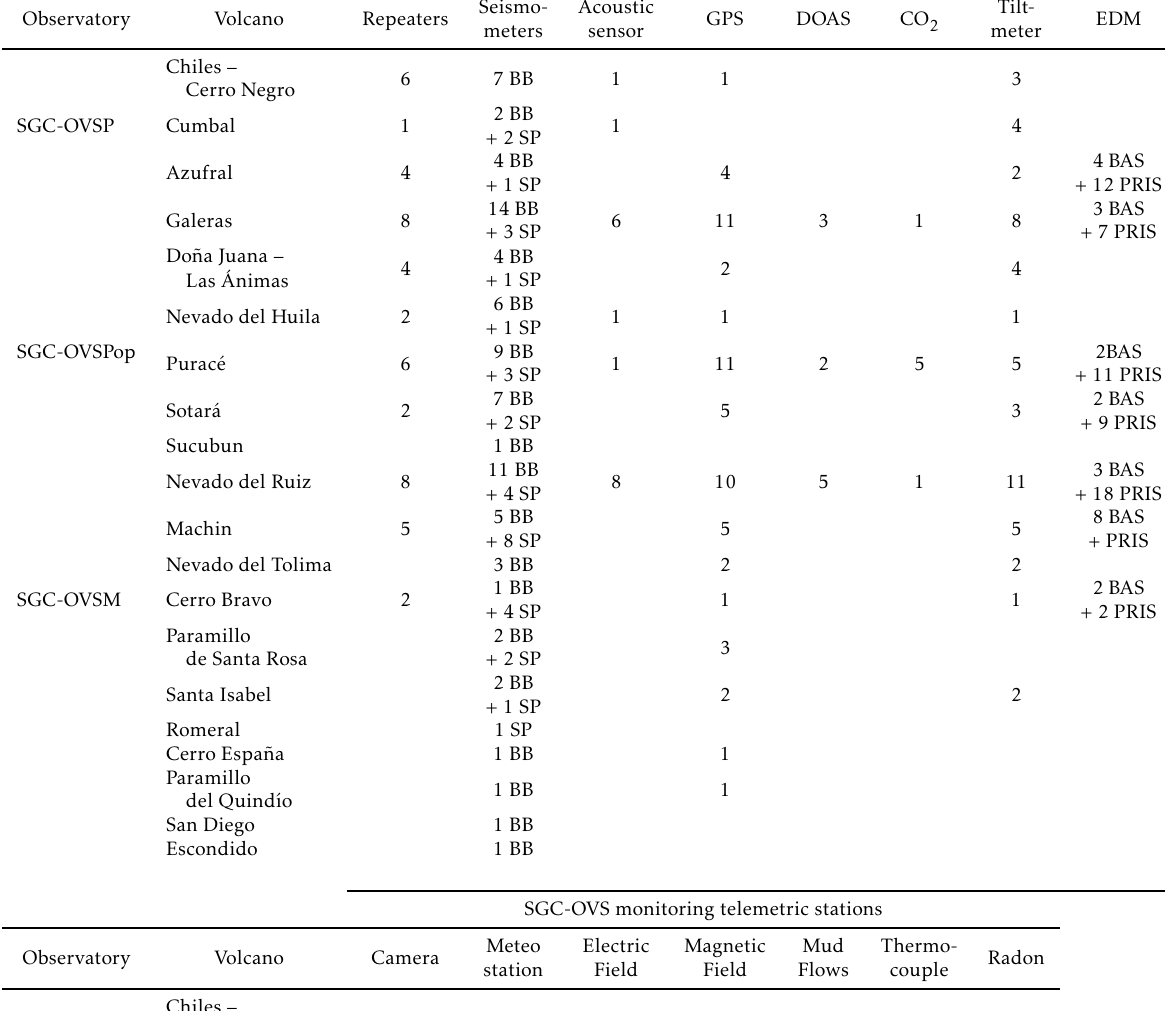
Table 1: Different techniques and instruments used by the Observatorios Vulcanológicos y Sismológicos of Pasto, Popayan and Manizales of the Servicio Geológico Colombiano (SGC-OVS) for monitoring the active Colombian volcanoes. BB = Broad Band, SP = Short Period. For EDM (Electronic Distance Measurement), BAS = Base, PRIS =